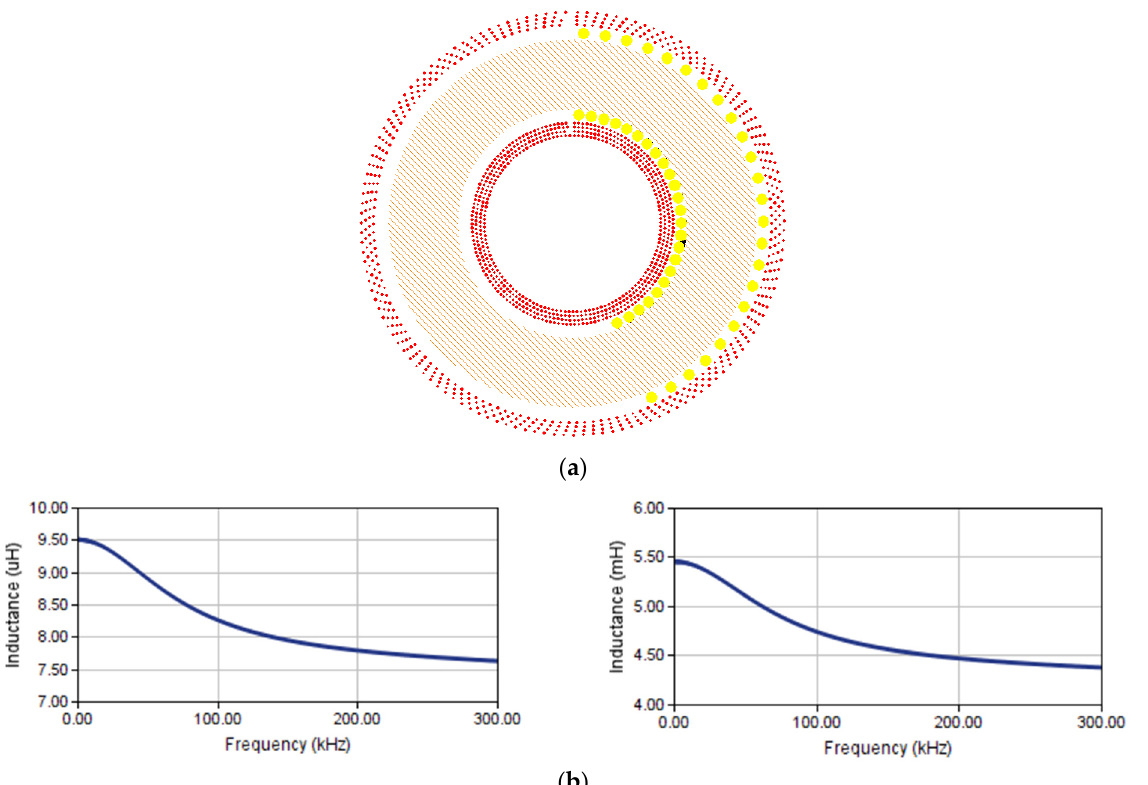
Figure 3. ( a ) Toroidal transformer in ANSYS Maxwell 2D environment. ( b ) Leakage inductance. Table 1. Toroidal transformer dimensions [11].